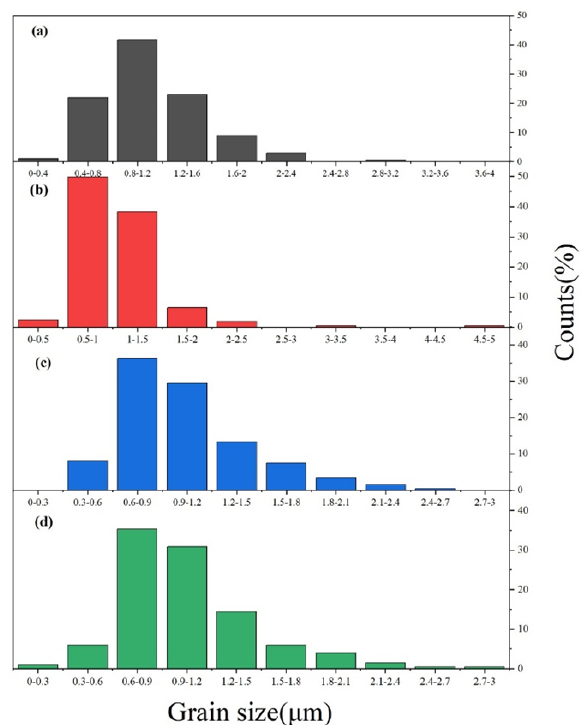
Fig. 2 Grain size distributions of KNNS–0.04BNKZ–